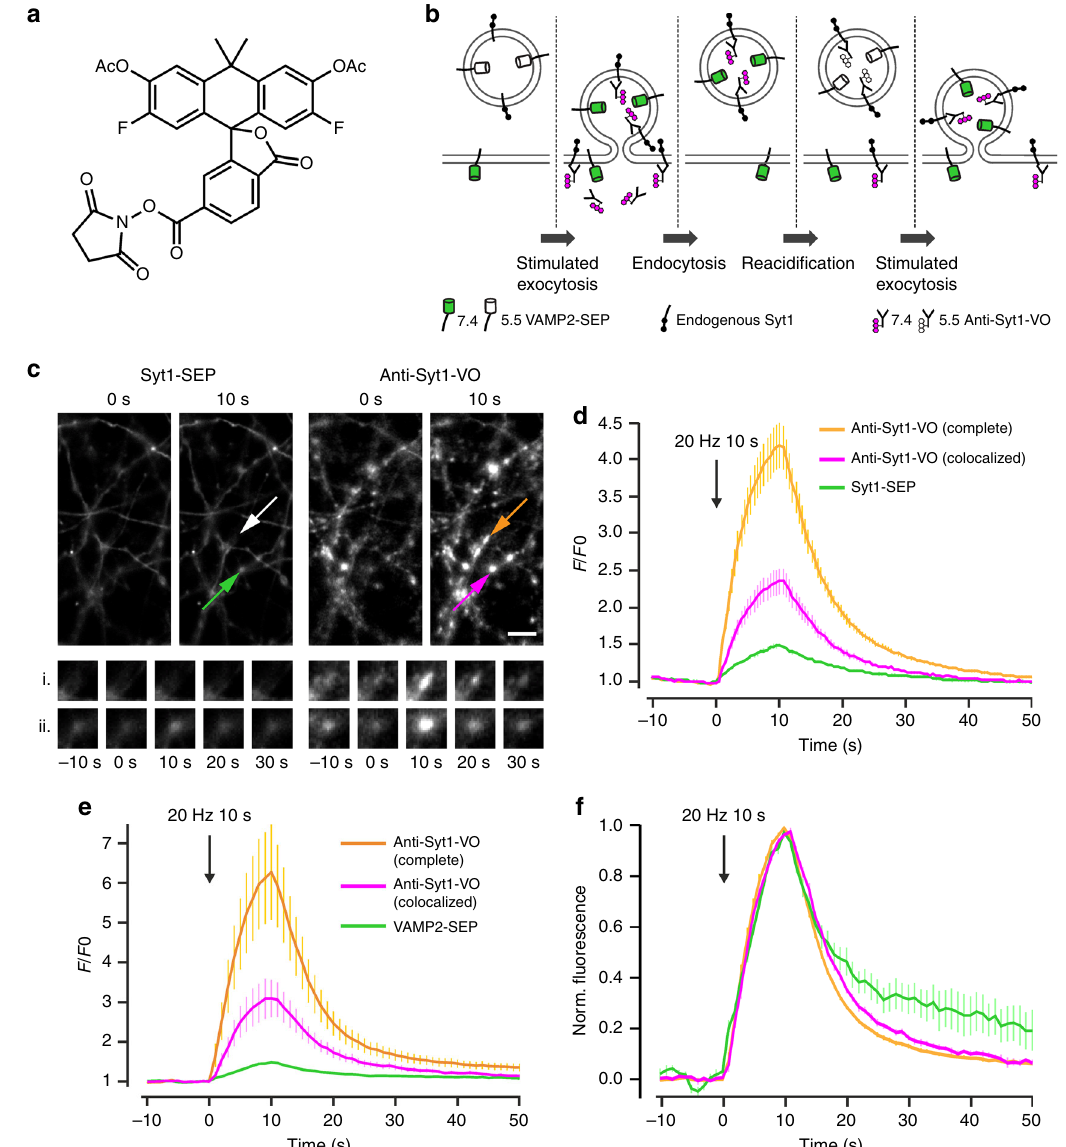
Fig. 4 Detection of synaptic vesicle exocytosis with labeling of endogenous proteins. a Chemical structure of VO-NHS ester (6). b Protocol for staining with anti-Syt1-VO. c Fluorescence images of hippocampal axons expressing Syt1-SEP and stained with anti-Syt1-VO with the locations of vesicle fusion indicated with arrows (top); scale bar: 5 µ m. Bottom, time-lapse images of the exocytosis events in boutons containing only anti-Syt1-VO (i) or containing both Syt1- SEP and anti-Syt1-VO (ii). d Average anti-Syt1-VO (magenta) and Syt1-SEP (green) fl uorescence signals colocalized in the same boutons, and average anti- Syt1-VO fl uorescence signals present in the complete neuronal population (orange) in response to fi eld stimulation for 10 s at 20 Hz; n = 41. e Same as d for neurons transfected with VAMP2-SEP. Average anti-Syt1-VO (magenta) and VAMP2-SEP (green) fl uorescence signals colocalized in the same boutons, and average anti-Syt1-VO fl uorescence signals present in the complete neuronal population (orange); n = 10. f Average normalized traces corresponding to the recordings in e . Fluorescence decay after stimulation was 10.6 ± 1.9 s for VAMP2-SEP, 7.9 ± 0.4 s for anti-Syt1-VO co-localized with VAMP2-SEP, and 6.5 ± 0.2 for all boutons ( n = 10 fi elds). Data are represented as mean ±